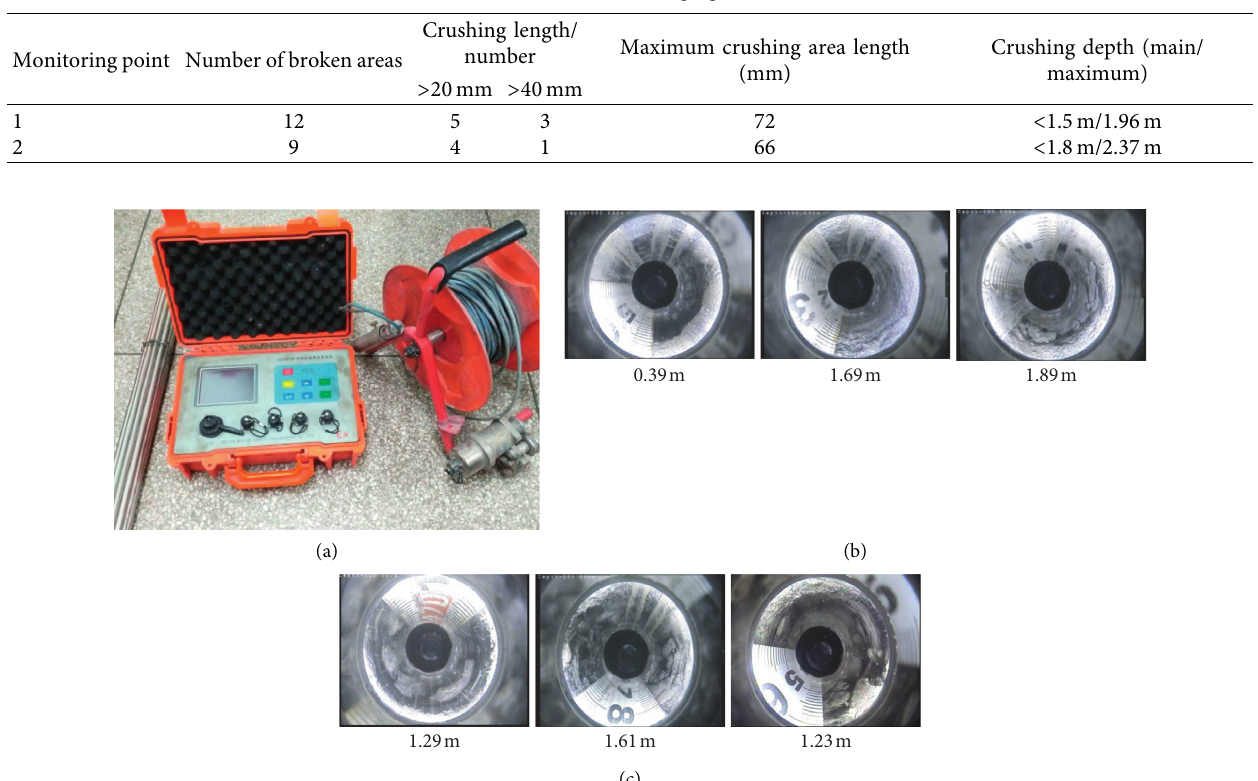
Figure 7: Borehole imaging instrument and detection results. (a) TYGD10 rock drilling detector. (b) Borehole image screenshot at point 1. (c) Borehole image screenshot at point